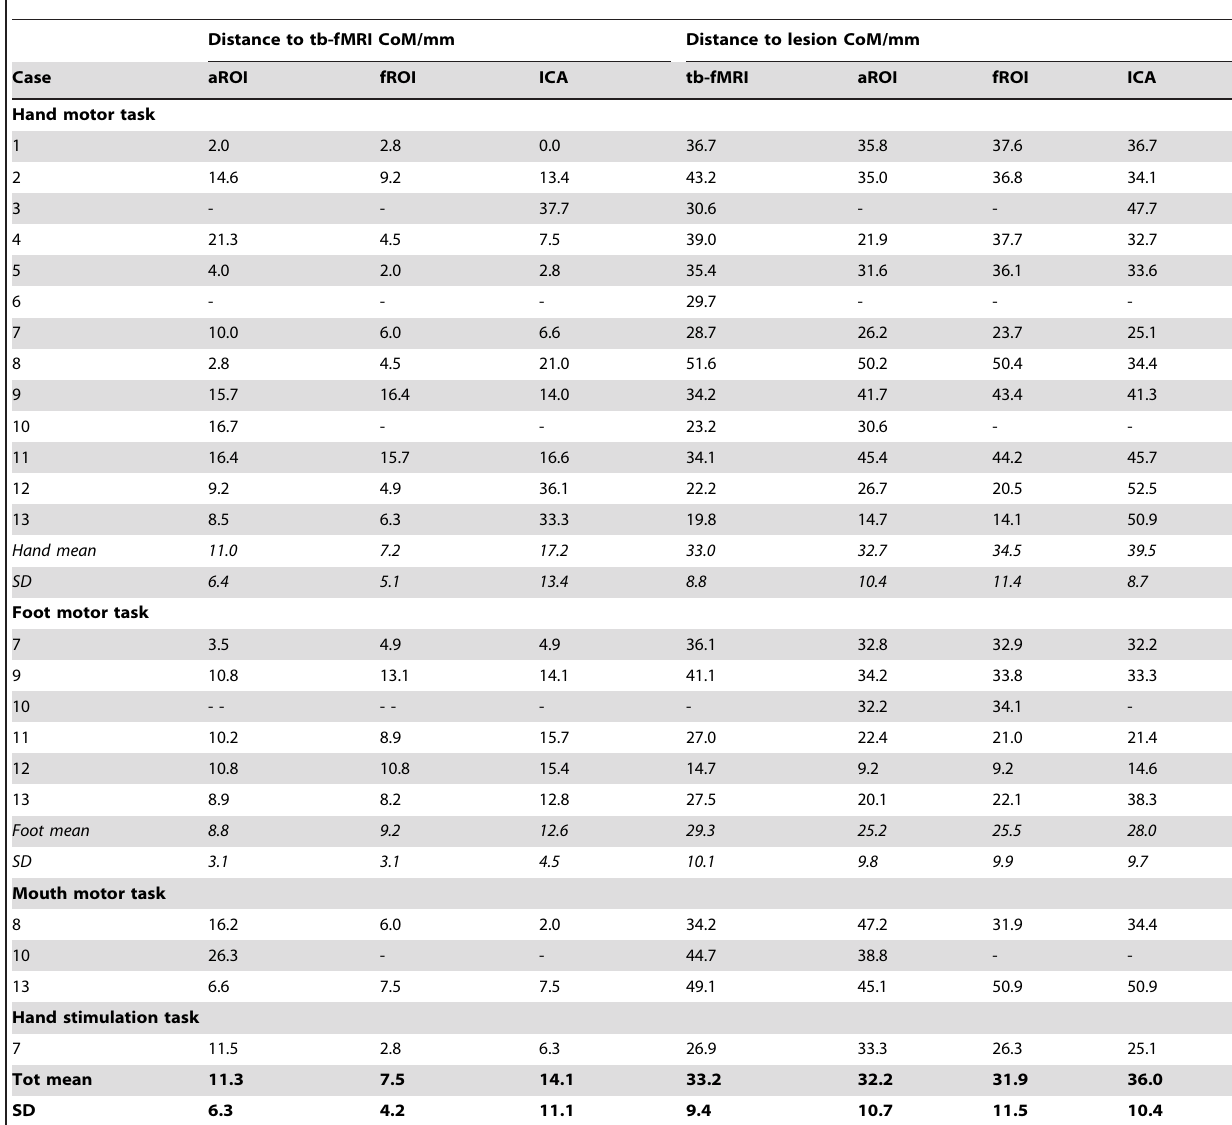
Table 6. Centre-of-mass (CoM) distance measurements obtained with operator-dependent thresholds.